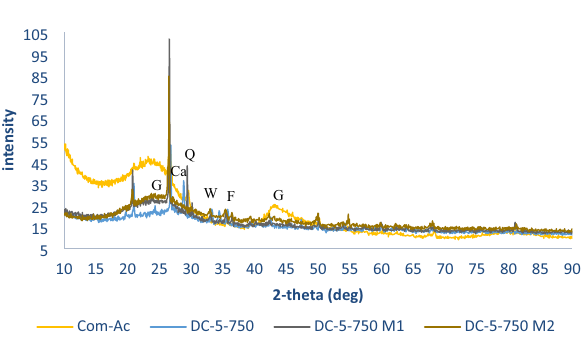
Figure 13. XRD spectra of Com-AC, unoxidized (DC-5-750) and its oxidized